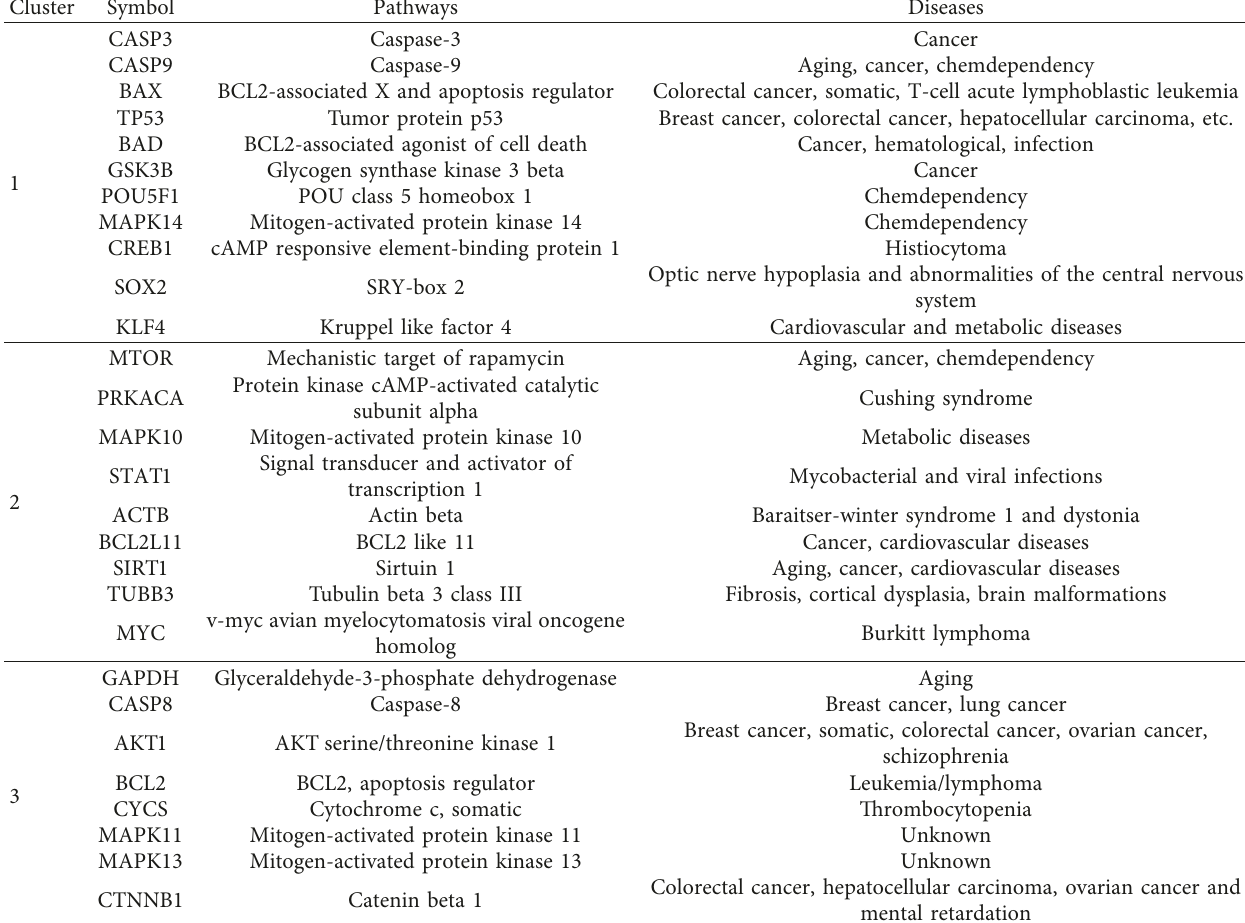
Table 3: Cluster details of MCODE protein-protein interaction and